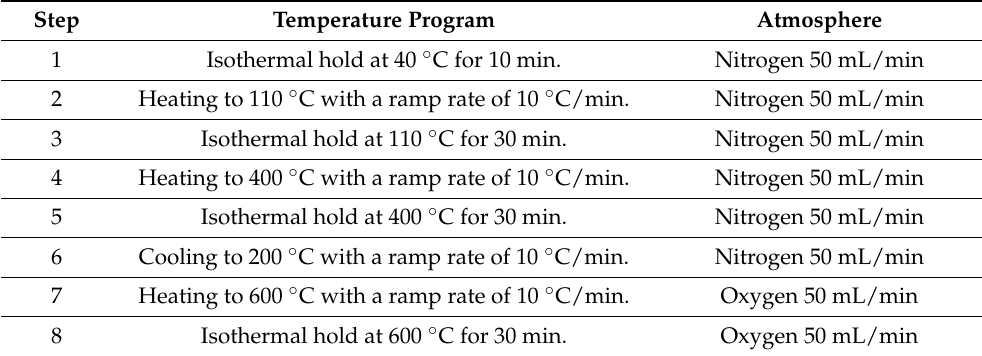
Table 3. Optimized manual TGA heating programmed